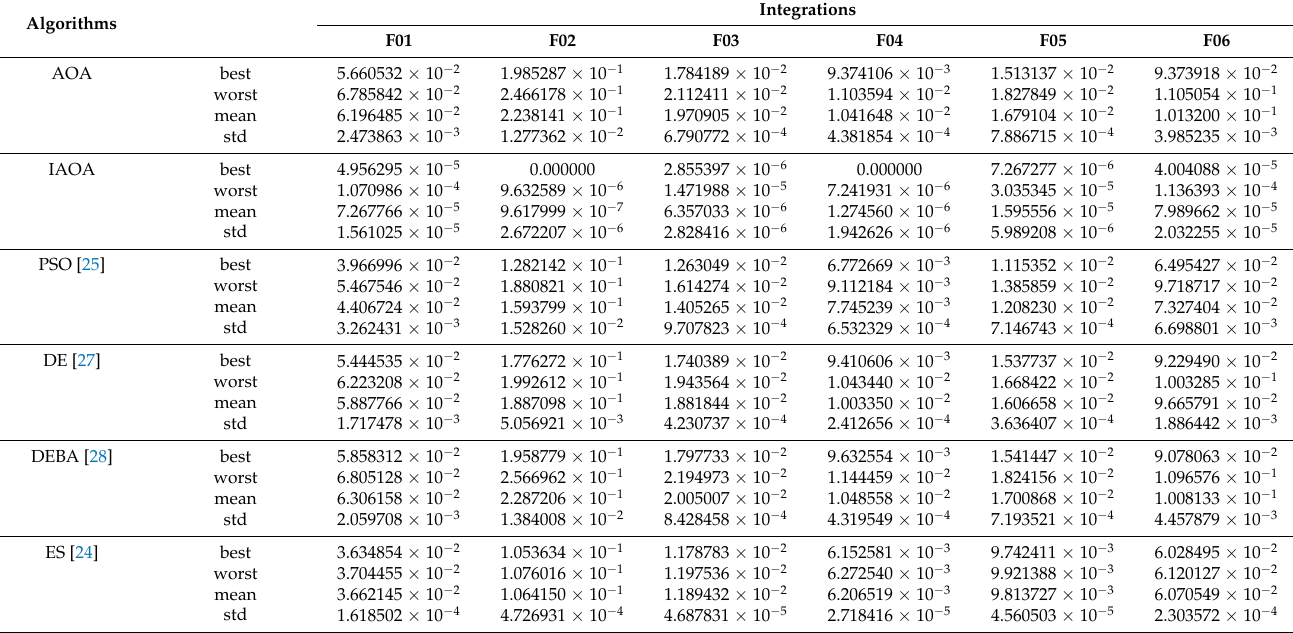
Table 13. Statistical results for the numerical integrations (F01–F06).